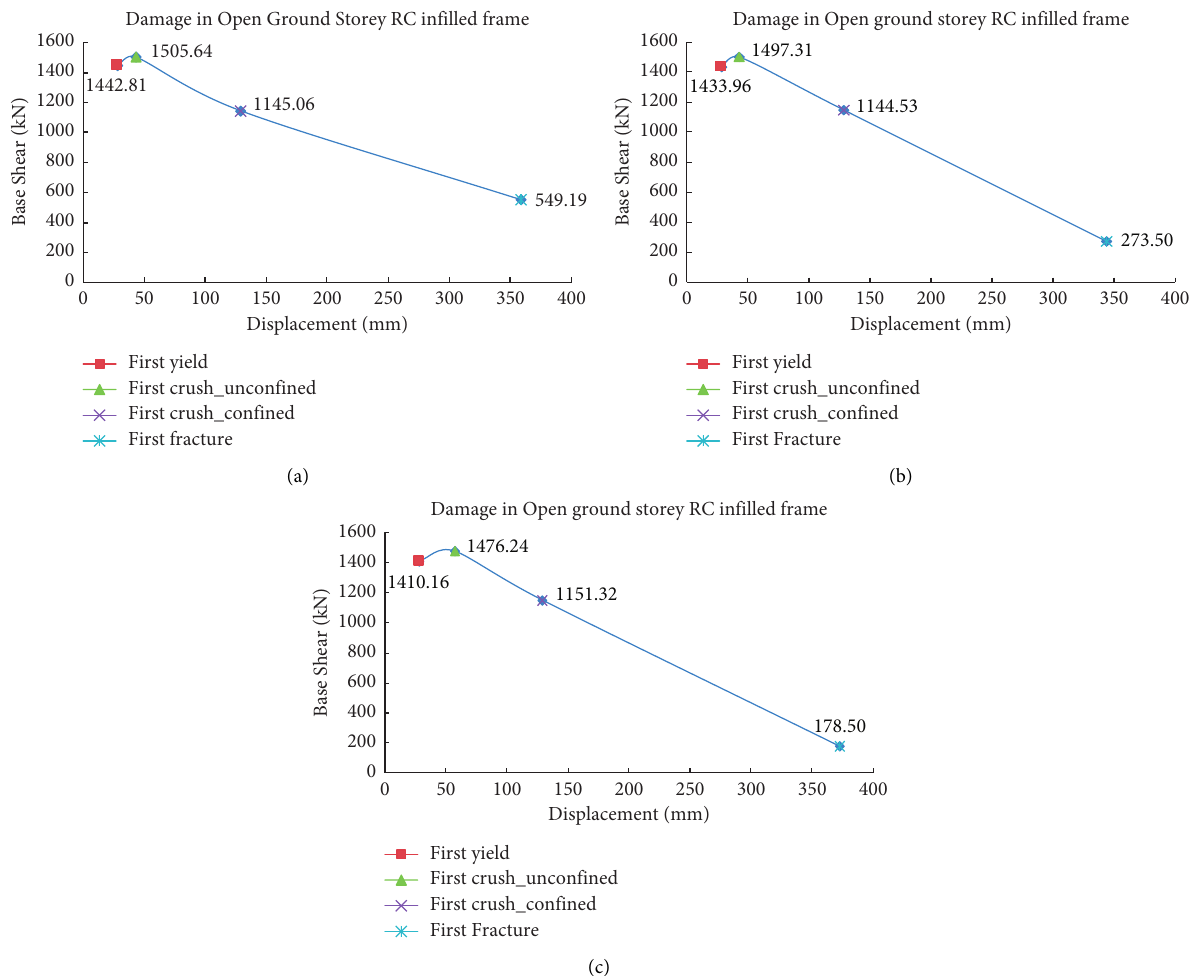
Figure 12: Damage in open ground story RC infilled frame for different values of the compressive strength of infill: (a) 5MPa; (b) 4MPa; (c)